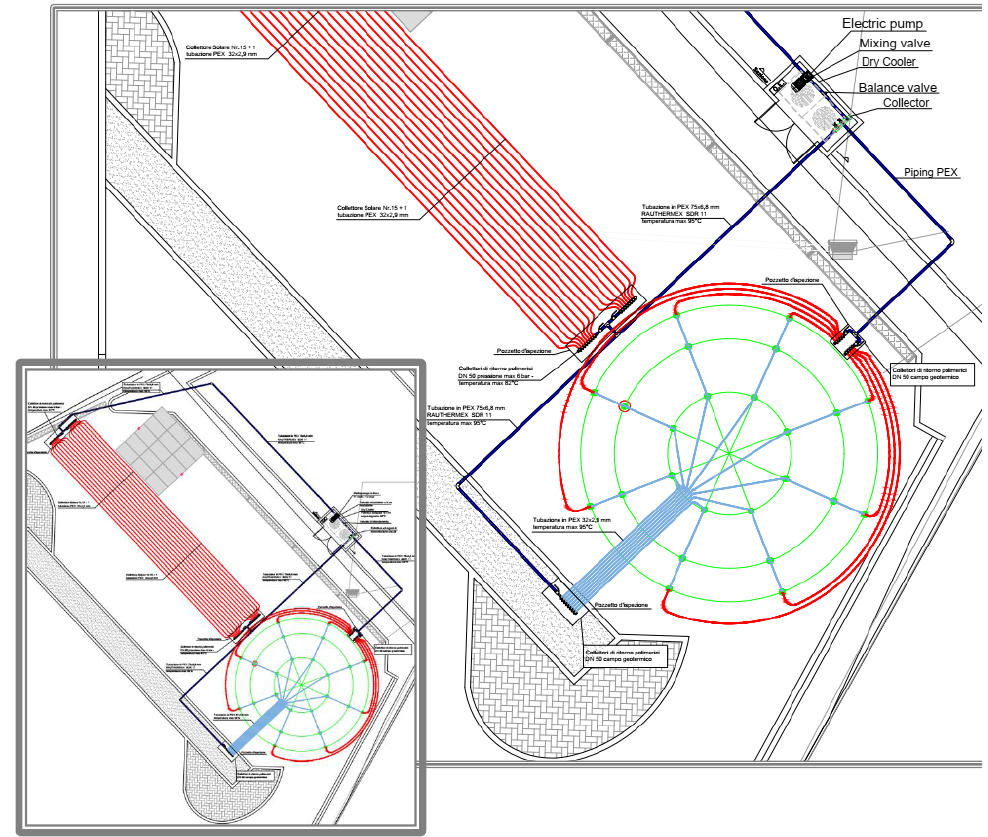
Figure 7. RTC + BTES schema of the experimental set-up.